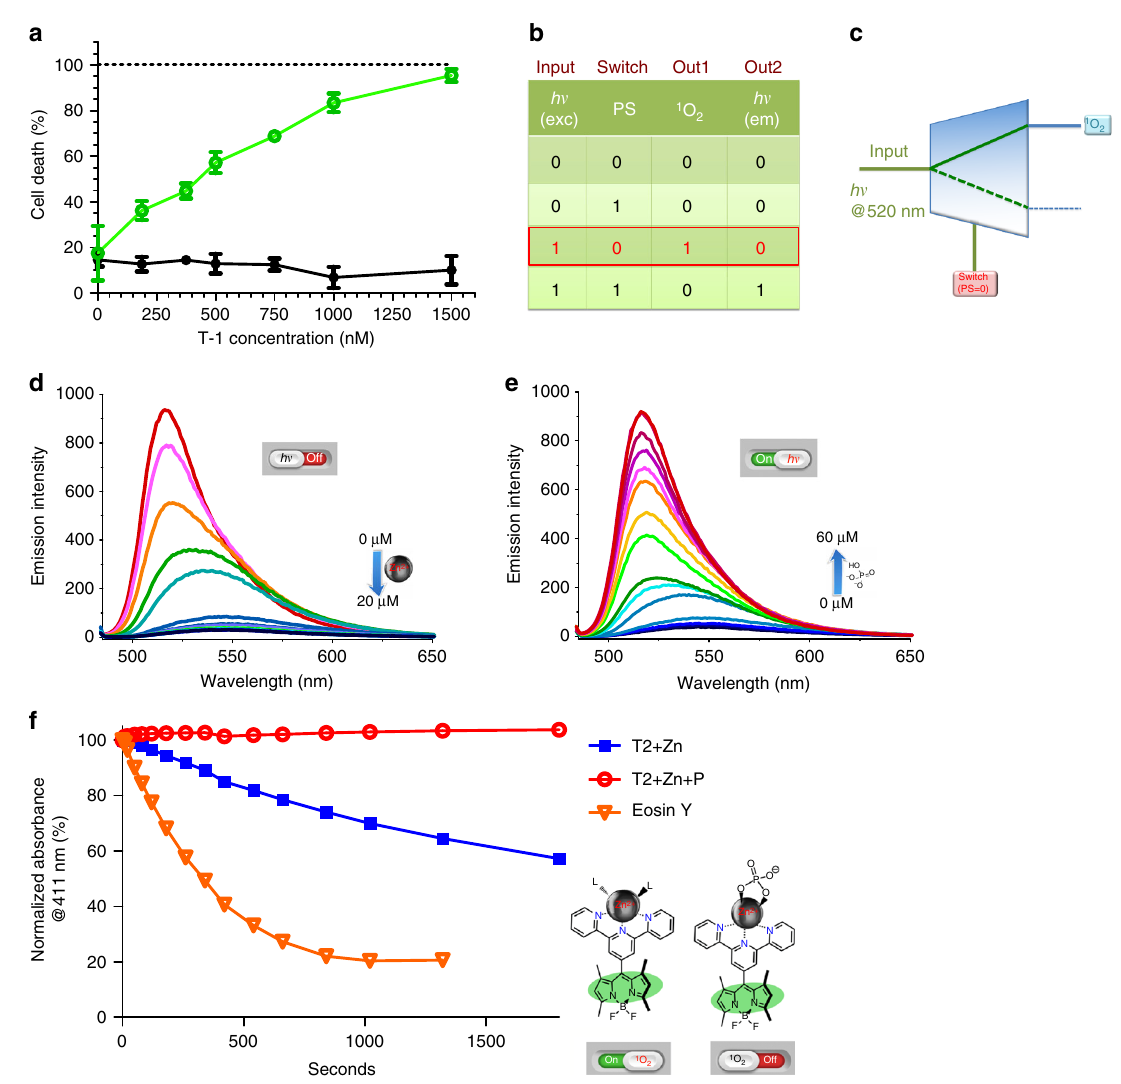
Fig. 3 Operation of the molecular automata as evidenced by spectroscopic and cell culture data. a MTT assay data: Green open circles correspond to percent death of K562 cells under irradiation at 522 nm for 12 h followed by continued incubation in dark for another 12 h. Solid black circles correspond to cells kept under identical conditions of incubation with the agent, but in dark. Positive control (dashes at 100% line) corresponds to cells incubated in DMSO-growth medium mixture (50/50, v / v ). b The truth table with the data and switch inputs, and the corresponding outputs clearly identi fi ed, and the particular set of conditions valid under the light irradiation conditions on power-up were highlighted. c Switch input 0 (no added phosphate in the model system or lack of phosphatidylserine (PS) in the external lea fl et of the cell membrane in the cell cultures) selects singlet oxygen as the primary output. d The model compound T-2 , which is the Zn 2 + complex of the meso -terpyridyl-bodipy compound, has a very low fl uorescence emission intensity in acetonitrile. e The addition of phosphate ions results in a very sharp increase in emission intensity. The low emission intensity is due to the availability of a charge transfer state (CTS) resulting in enhanced intersystem crossing, which in turn leads to ef fi cient generation of singlet oxygen. f The decrease in the absorbance at 411 nm, in an oxygen saturated ethanol solution of selective singlet oxygen trap DPBF (50 µ M) in the presence of 2.0 µ M T-2 and under irradiation with 522 nm green LED light source (solid blue squares). The